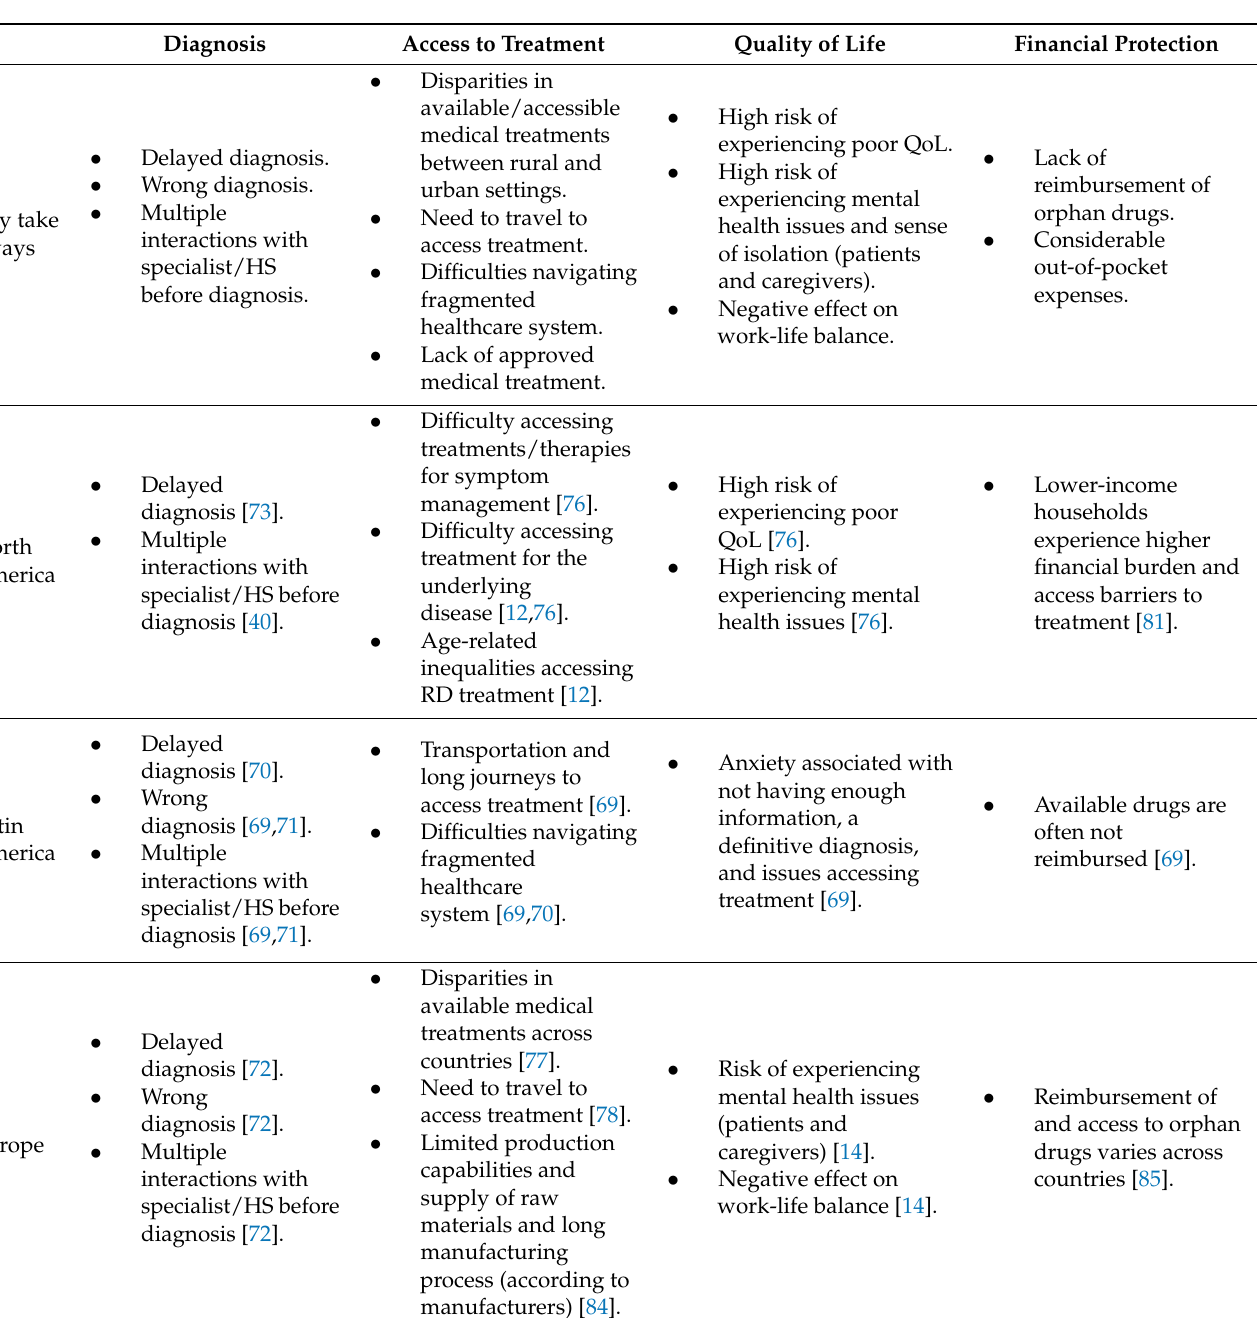
Table 1. Overview of challenges faced by RD patients along the patient journey. Diagnosis Access to Treatment Quality of Life Financial